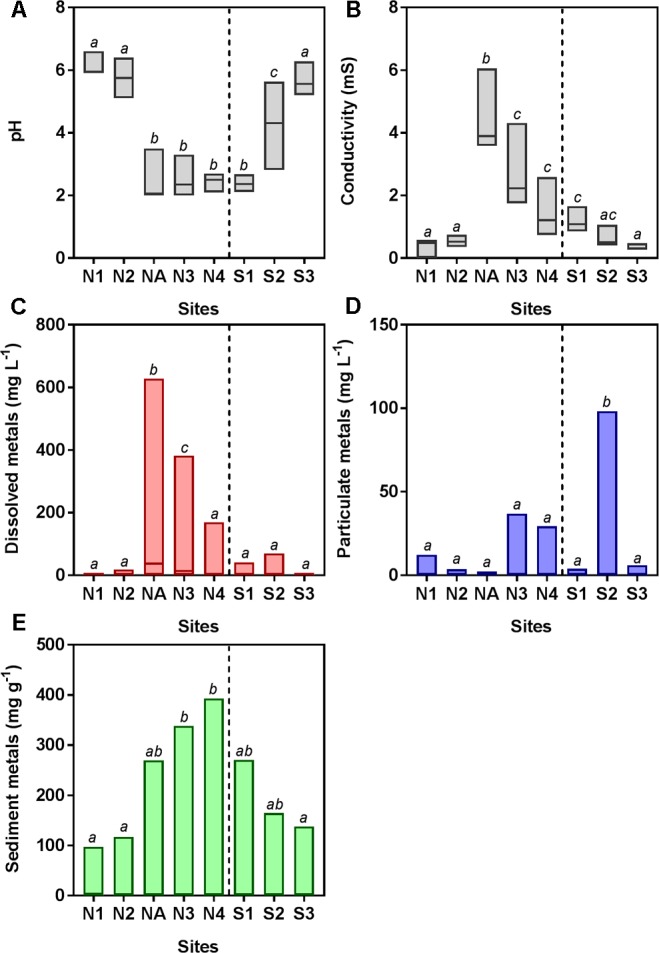
Water chemistry [(A) pH and (B) conductivity] and total metal concentration in water [(C) dissolved and (D) particulate] and (E) sediment samples. Data are pooled from triplicate analyses taken on four to seven sampling occasions (June 2010, July 2010, November 2011, August 2013, October 2013, March 2014, and October 2014). Boxes show the minimum and maximum values and the line within the boxes shows the median values. Boxes that do not share lowercase letters are significantly different (p < 0.05) as determined by one-way ANOVA. Data for individual metals (Al, As, Cd, Cu, Fe, Mn, Pb, and Zn) are shown in Supplementary Figure S1.